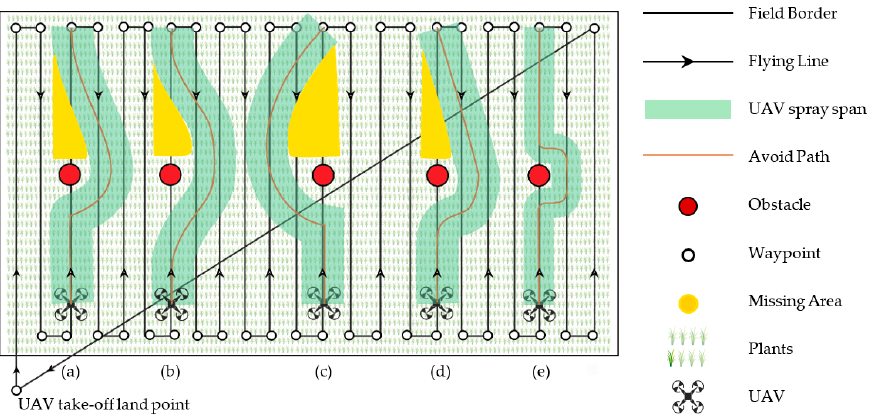
Figure 1. Traditional algorithms for sprayer UAV’s operations and expected path: ( a ) sliding circle [22], ( b ) cross-entropy [23], ( c ) potential field [40], ( d ) collision cone [29], ( e ) expected path.